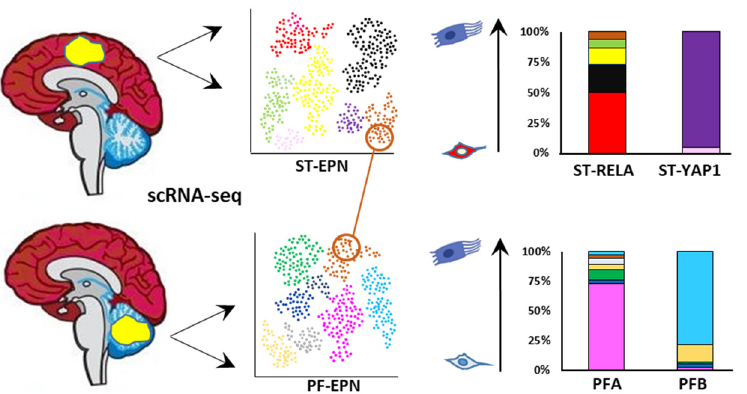
Figure 5. Intra-tumoral heterogeneity in intracranial ependymoma by scRNA-seq. scRNA-seq of tumor cells is colored based on distinct gene signatures that define cell subpopulations. The relative frequency of each subpopulation is different in PFA tumors that are enriched for undifferentiated cells vs. PFB tumors enriched for ependymal-like cells. ST-RELA tumors also harbor high fractions of progenitor cell subpopulations, whereas a distinct ST-YAP1 gene signature is overrepresented in ST-YAP1. Some overlap between transcriptional signatures is observed across EPN groups.